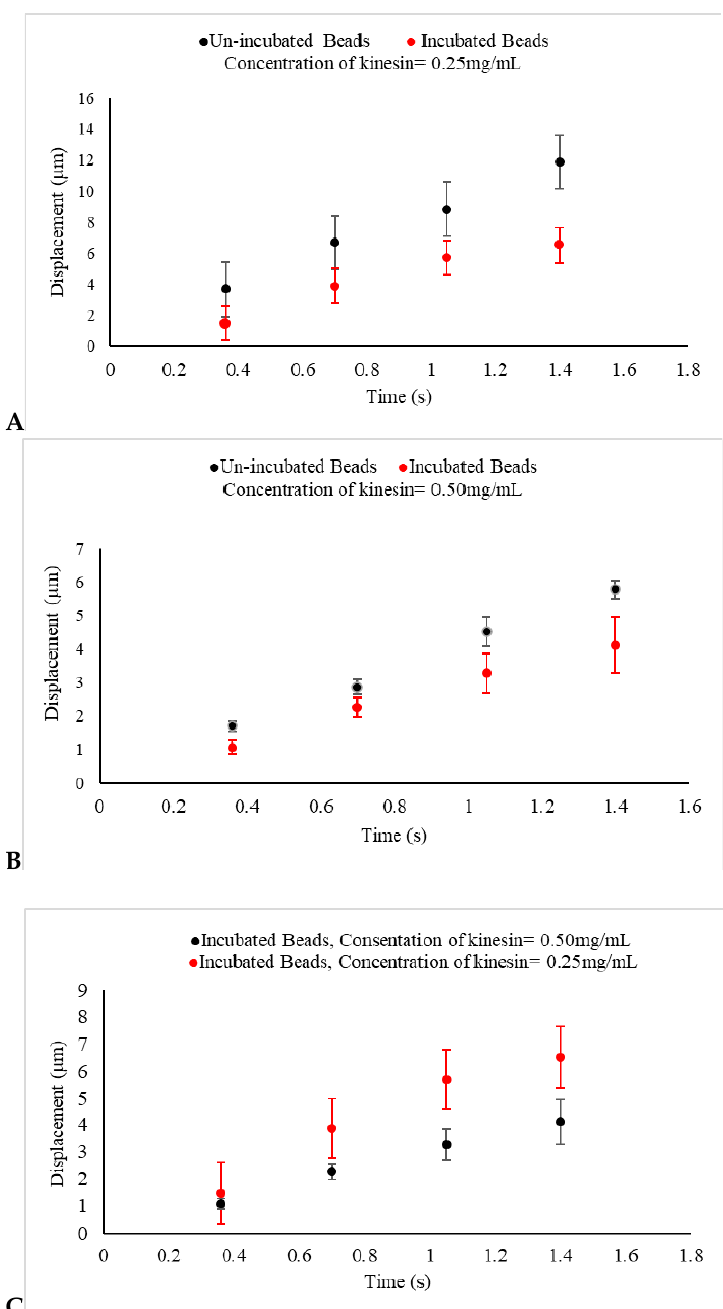
Figure 4. ( A , B ) The displacements of un-incubated kinesin beads (Black) and incubated beads in 0.25 mg / mL and 0.5 mg / mL kinesin-1 (Red) under an electric field produced by 1.5 V are presented. In un-incubated samples in both concentrations, the displacements of beads are reduced, as compared with beads in the control experiments, as shown in Figure 3A. The displacements of incubated beads are also seen to be reduced, as compared with un-incubated beads under the same experimental conditions. This indicates that the negative charge of prepared beads used in the control experiment is decreased because of the positive charge of kinesin proteins adhering to the beads. As expected, the reduction in displacement is more significant as the concentration of the protein increases; ( C ) The displacement of kinesin-coated beads, incubated in 0.25 mg / mL (Red) and 0.5 mg / mL kinesin protein (Black) for 30 min and under the same uniform electric field, are presented. This indicates that the negative charge of prepared beads is decreased even more by the greater concentration of the positive charge of kinesin proteins adhered to the beads.